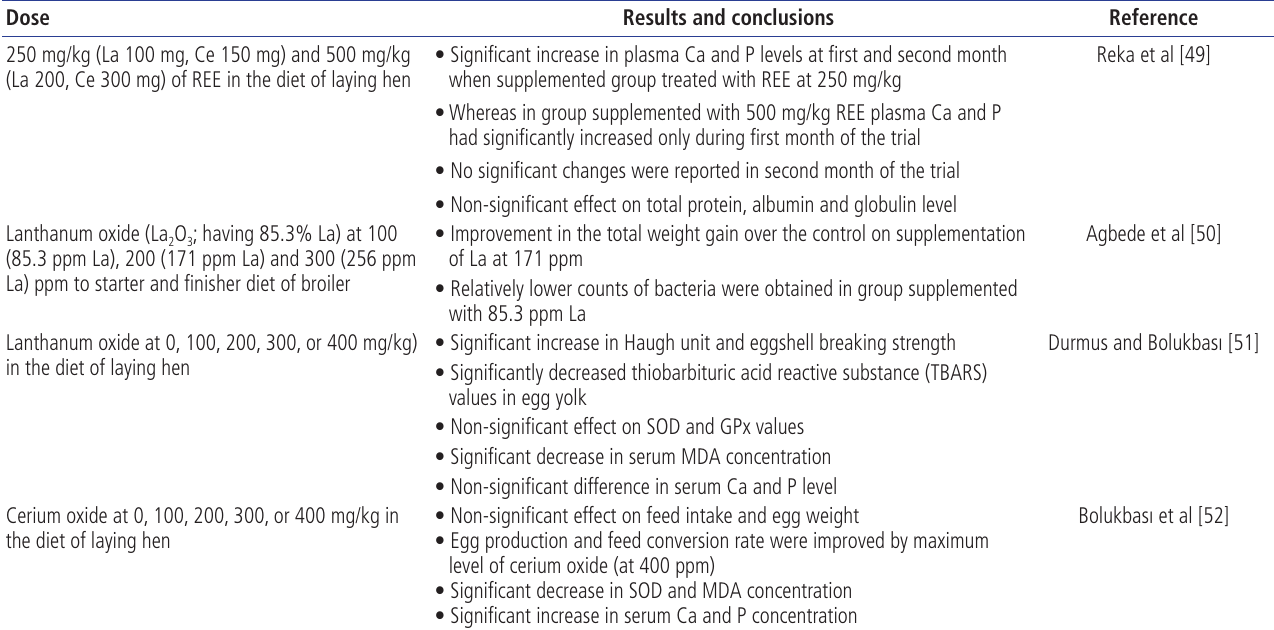
Table 2. Literature summary of effect of REE supplementation in poultry